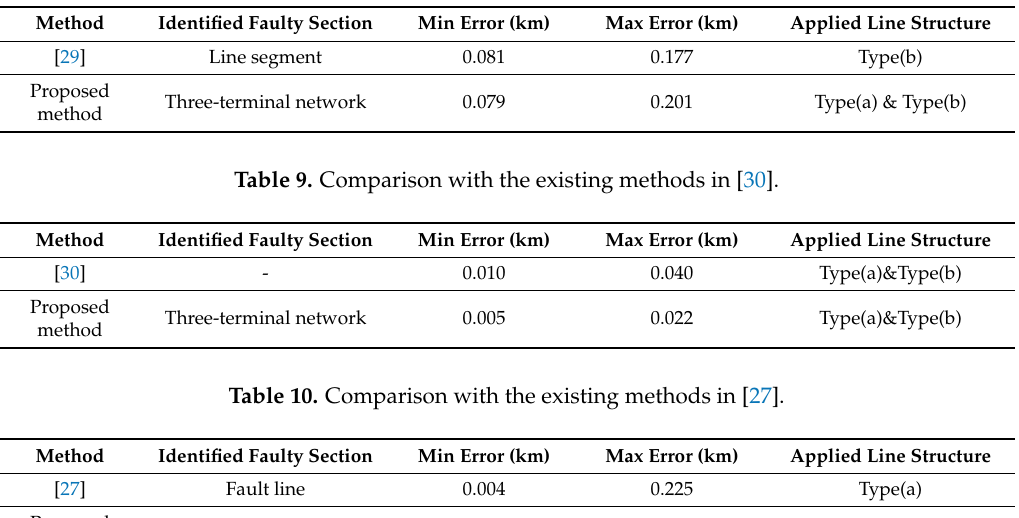
Table 8. Comparison with the existing methods in [29].